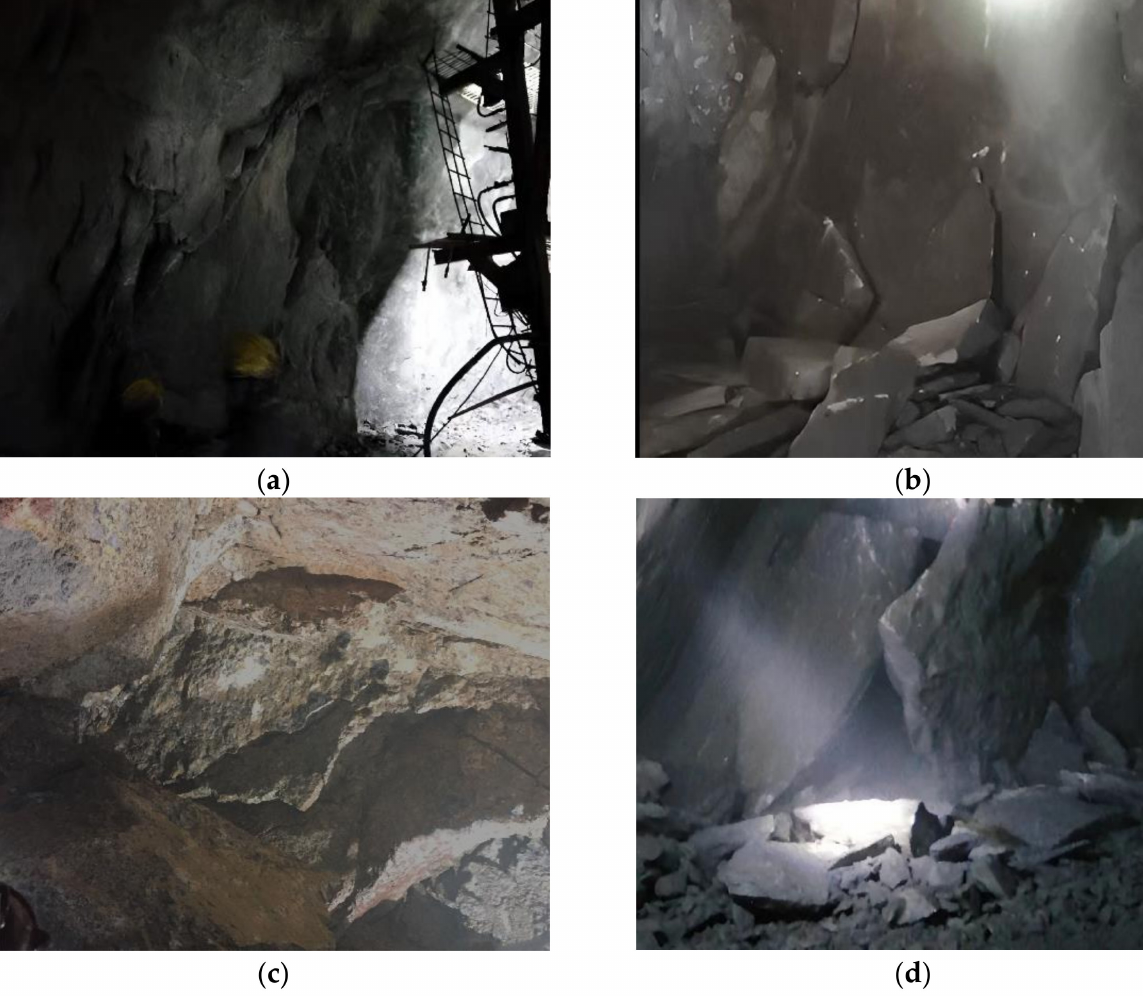
Figure 2. Rockburst phenomena on the site: ( a ) Weak rockburst; ( b ) moderate rockburst; ( c ) moderate rockburst; ( d ) heavy